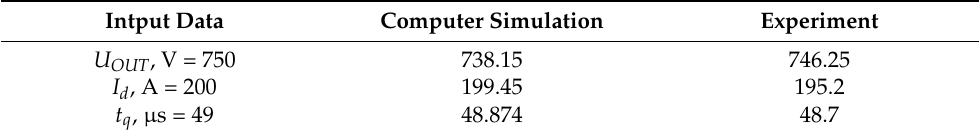
Table 1. Output data and obtained results from simulation and experiment for full-bridge current source